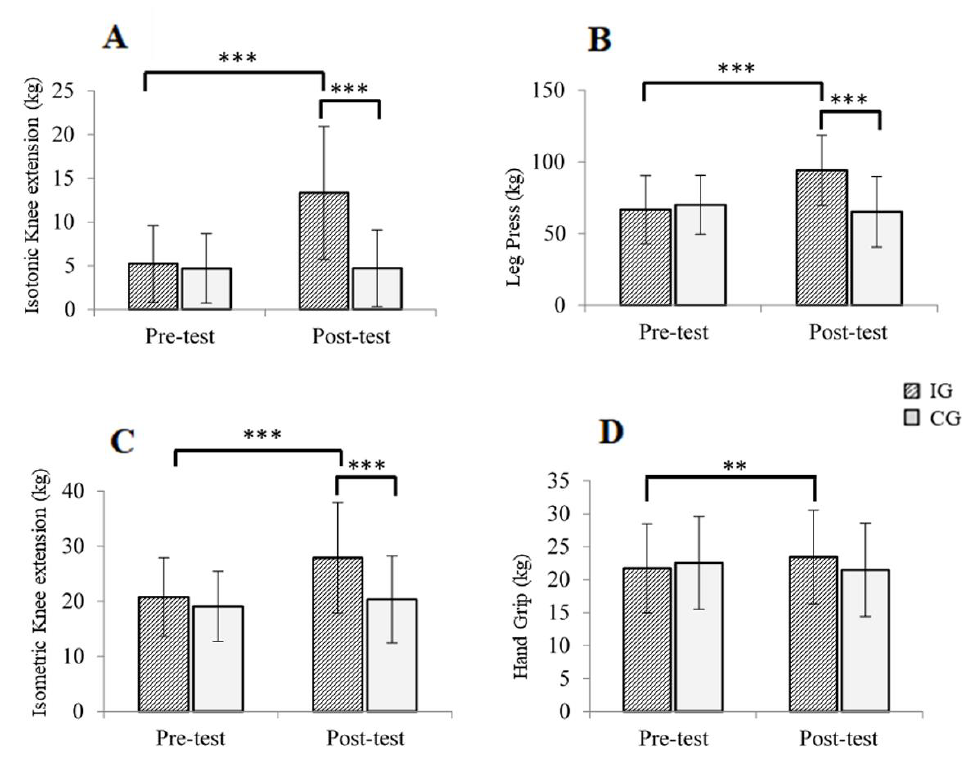
Figure 3. Comparative analysis pre and post-test after PROMUFRA upon: ( A ) isotonic knee extension; ( B ) leg press; ( C ) isometric knee extension; ( D ) hand grip. IG: Intervention Group; CG: Control Group; All values are expressed in kg. Statistical significance: ** p < 0.01; *** p < 0.001.